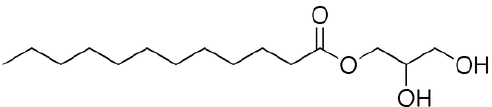
Figure 12. The molecular structure of the main component in the biobased surfactant.